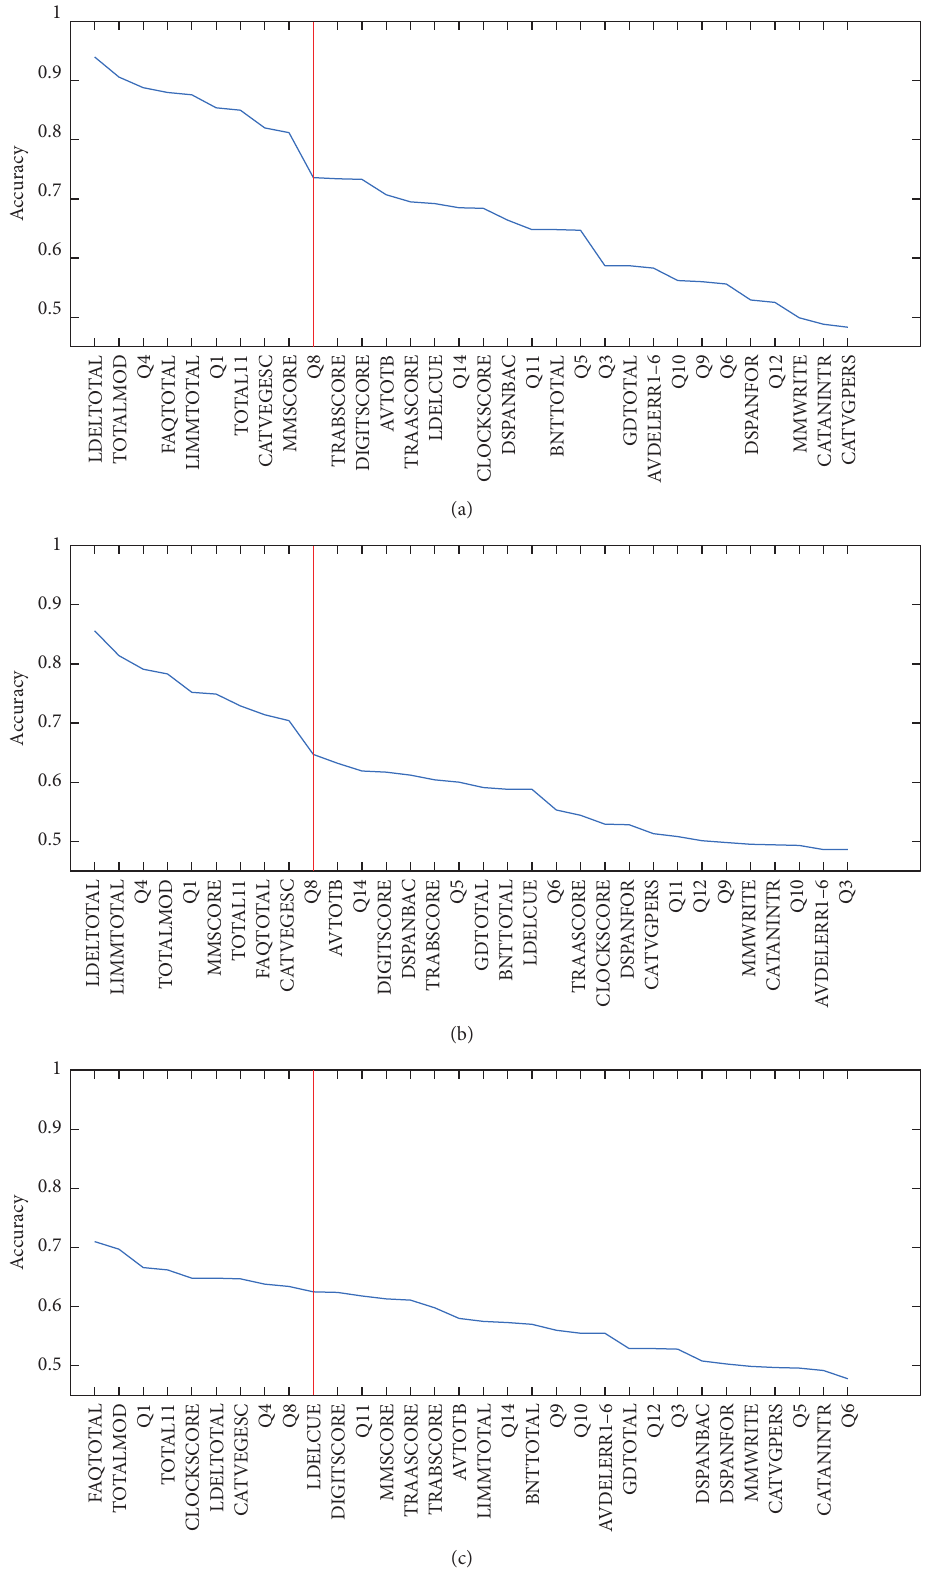
Figure 2: Features ordered according to their individual classification accuracy for CDR = 1 versus CDR = 0 (a), CDR = 0.5 versus CDR = 0 (b), and CDR = 1 versus CDR = 0.5 (c), using the feature reduction guided by the neuropsychologists. Results were obtained as average across all rounds (10) and iterations (100) but for each feature independently. Features are ranked in descending significance with respect to